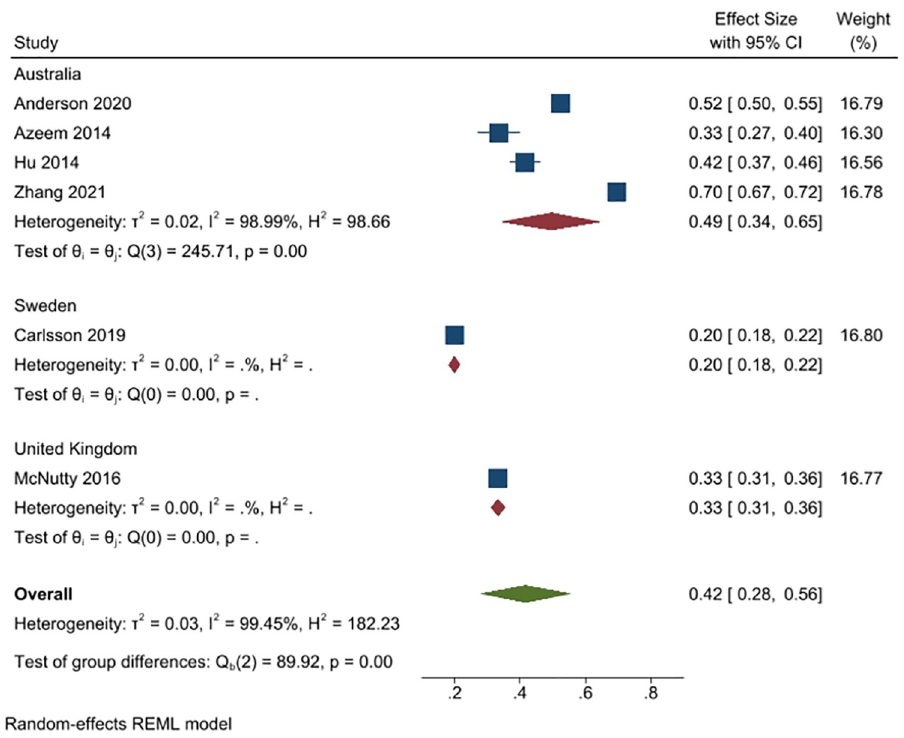
Fig 3. Percentage of respondents answering yes to the question of whether they consumed an antibiotic in the previous 12 months.